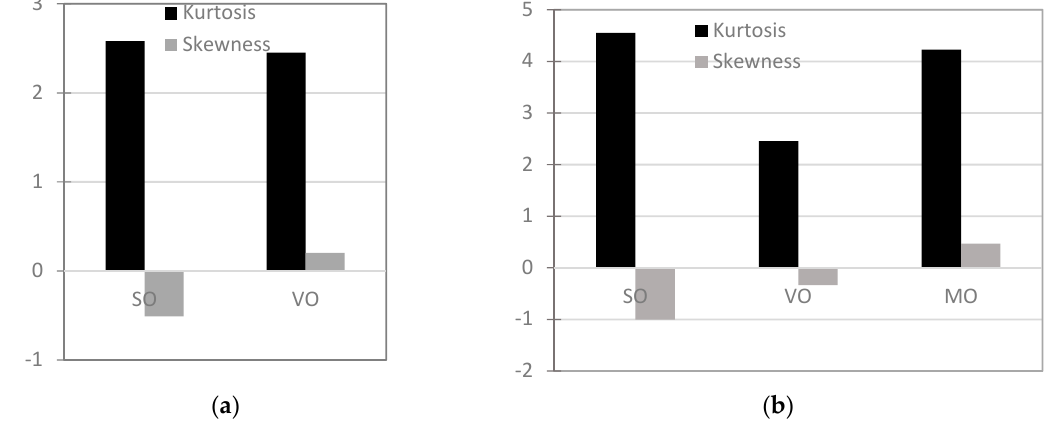
Figure 8. Coefficients of asymmetry and flattening of the normal distribution of AC ( a ) and DC ( b ) breakdown voltages of oils.